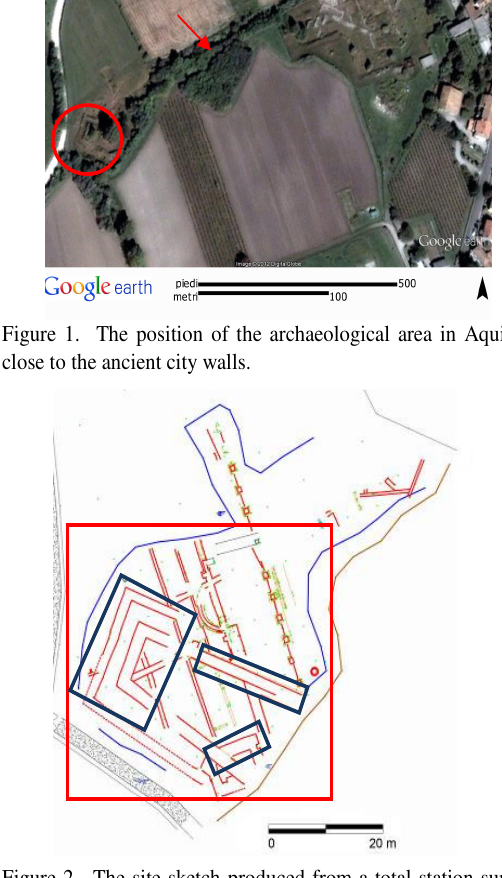
Figure 2. The site sketch produced from a total station survey showing the areas surveyed with UAV and TLS laser scanner (red) as well as with photogrammetry (blue).